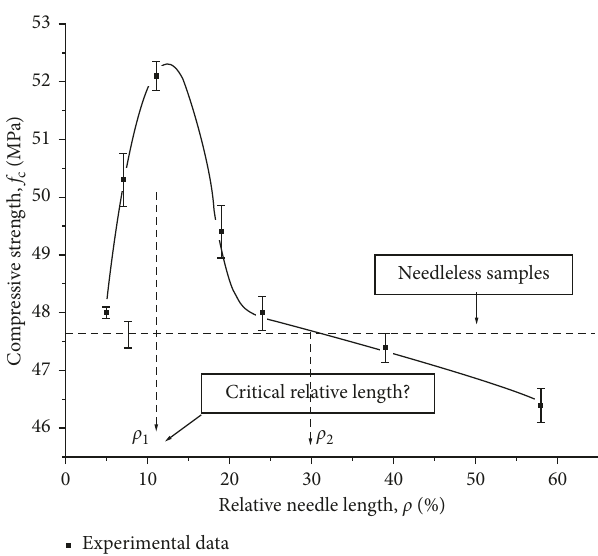
Figure 7: Compressive strength of cement mortar with embedded steel needles of various